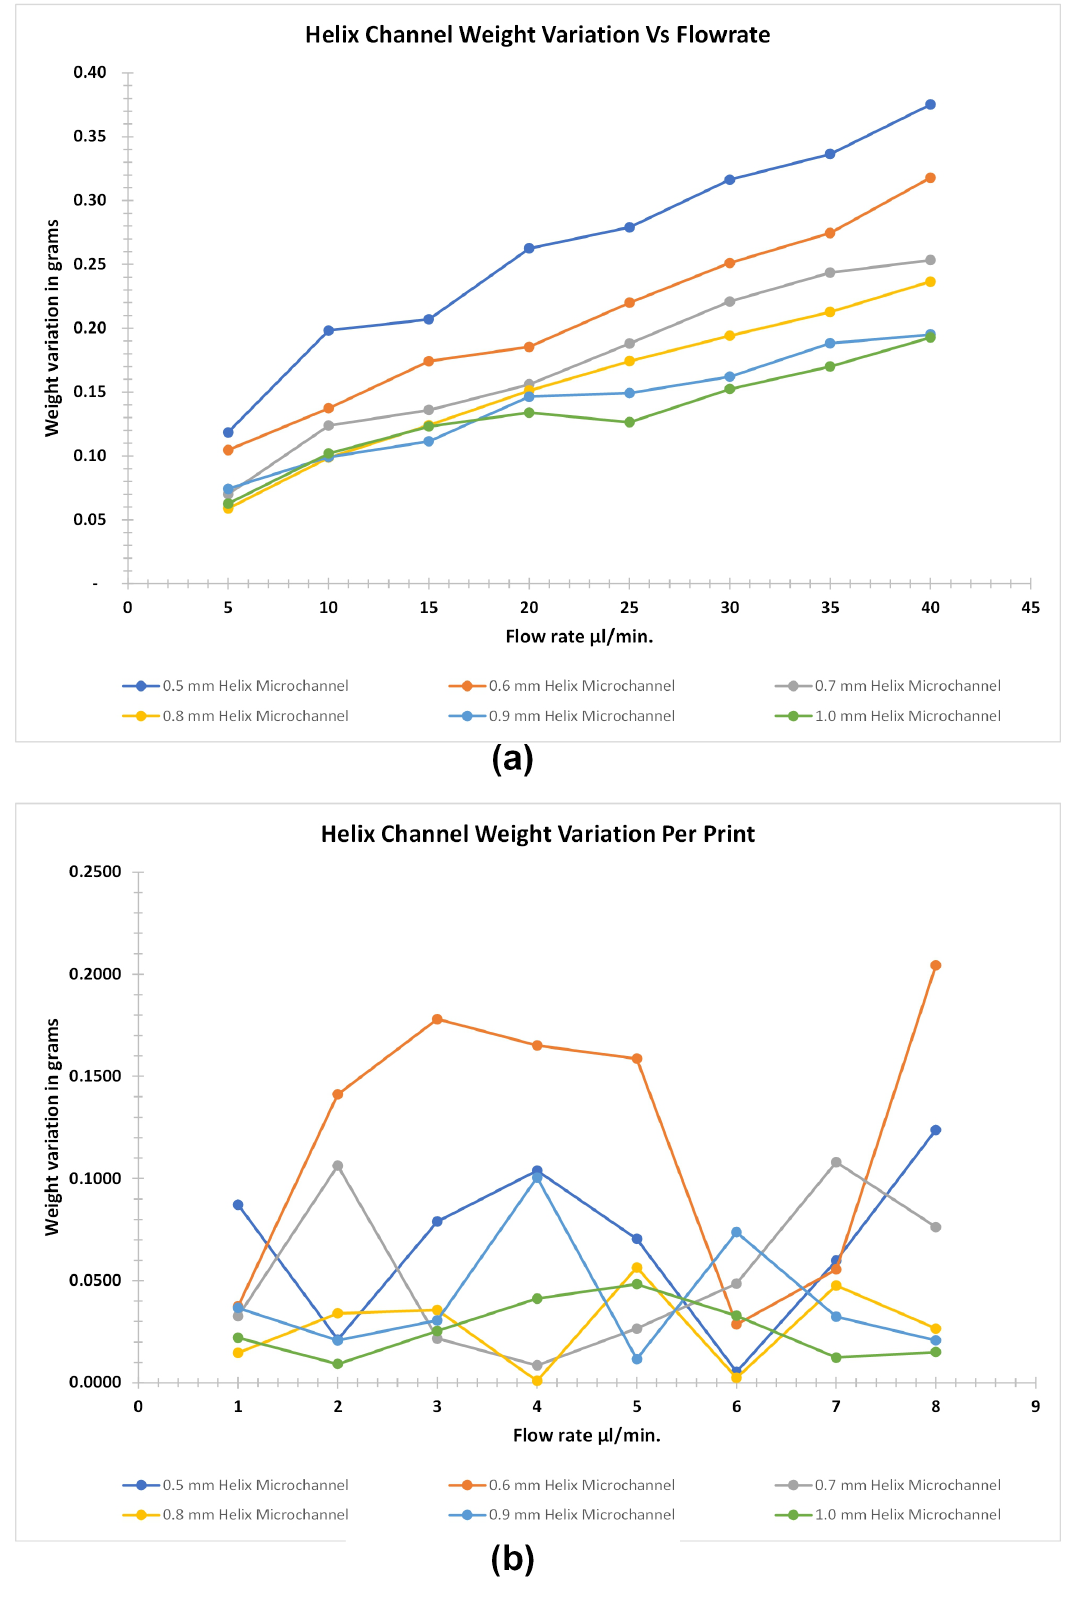
Figure 11. Weight analysis of helical microchannel. ( a ) Water retention with respect to flow rate of diameter size of 500 µ m to 1 mm microchannel with an increment of 100 µ m ( b ) Weight variation per printing of FDM parts for helical microchannel from 500 µ m to 1 mm